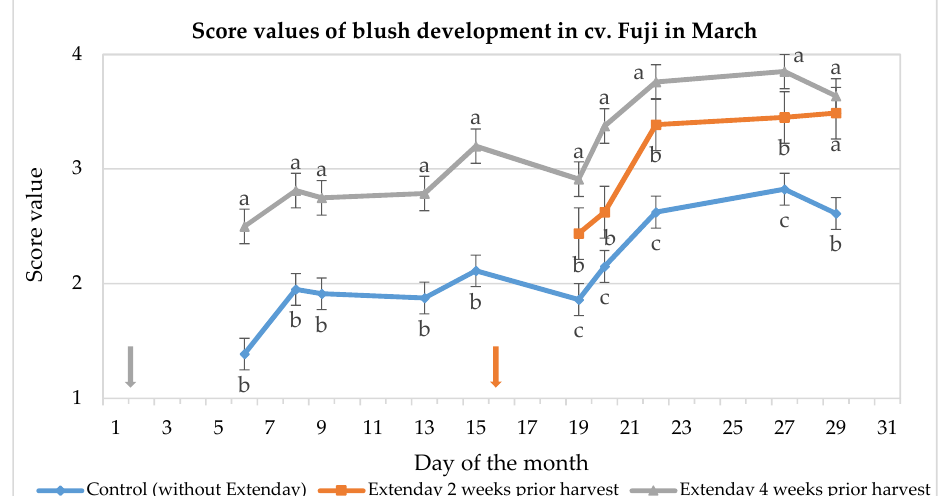
Figure 5. Score values of blush development in cv. Fuji in March as dependent on the timing of reflective mulch (average of fruit from the inside and outside of the tree canopy). (plus SEs; Different letters denote statistical differences within the same date at the p = 0.05 level (n = 80 fruit per treatment per pick.) Arrow indicates day of laying the mulch.